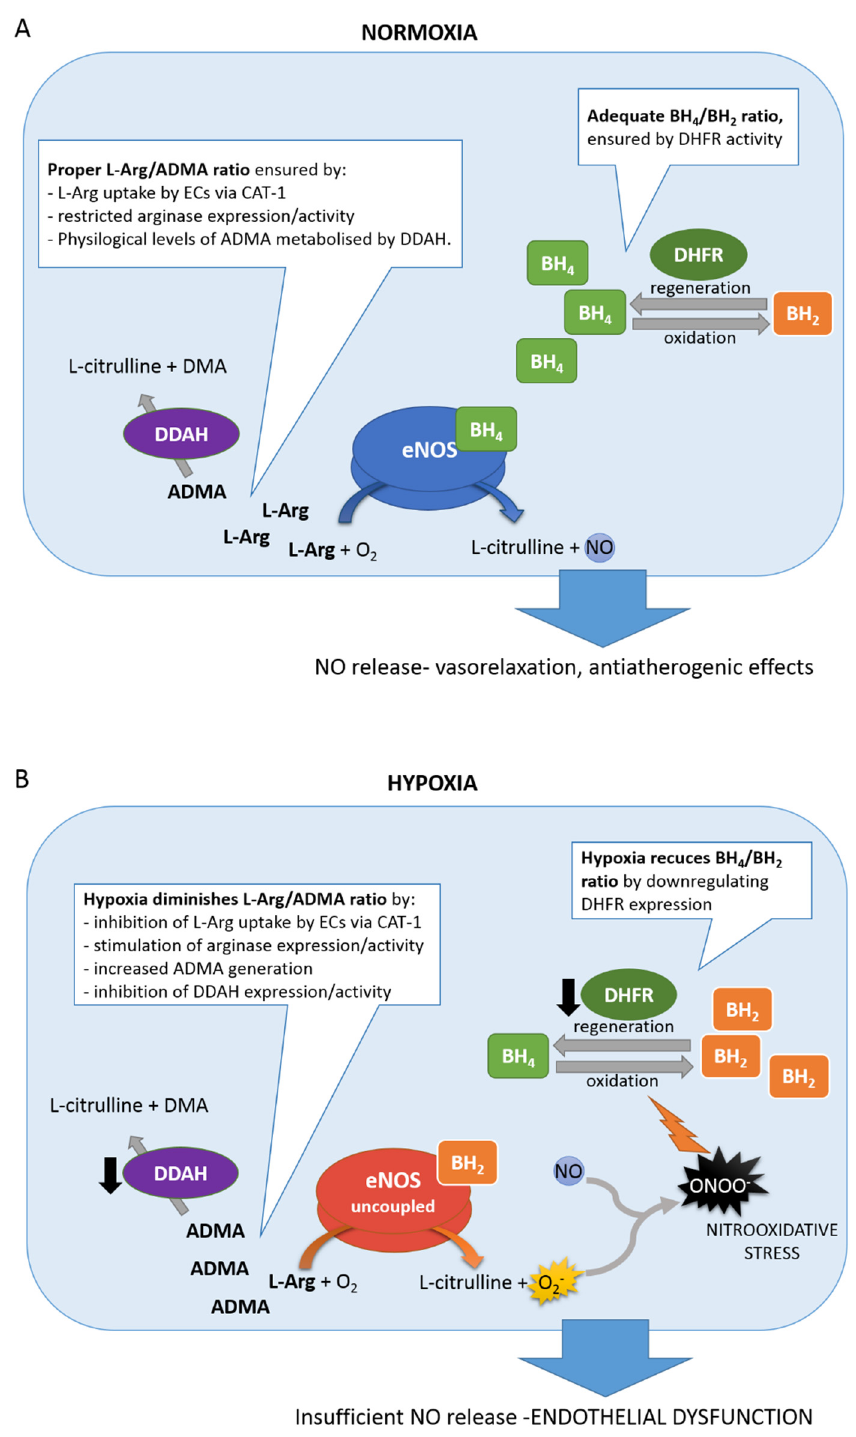
Figure 2. ( A ) In normoxic endothelial cells, eNOS in its “coupled” state produces appropriate amounts of NO, which protects against atherogenesis. ( B ) Under hypoxic conditions, DHFR ex- pression and activity are diminished. ADMA accumulates as a result of increased PRMT activity and inhibition of DDAH expression and activity, while intercellular L-Arg levels are reduced due to inefficient transport and increased arginase activity. Decreased L-Arg/ADMA and BH 4 /BH 2 ratios contribute to eNOS uncoupling and O 2 − generation. O 2 − reacts with NO (still produced in smaller quantities), leading to formation of ONOO − , which further oxidizes BH 4 , initiating the vicious cycle that results in oxidative stress. Reduced NO release (i.e., endothelial dysfunction) leads to